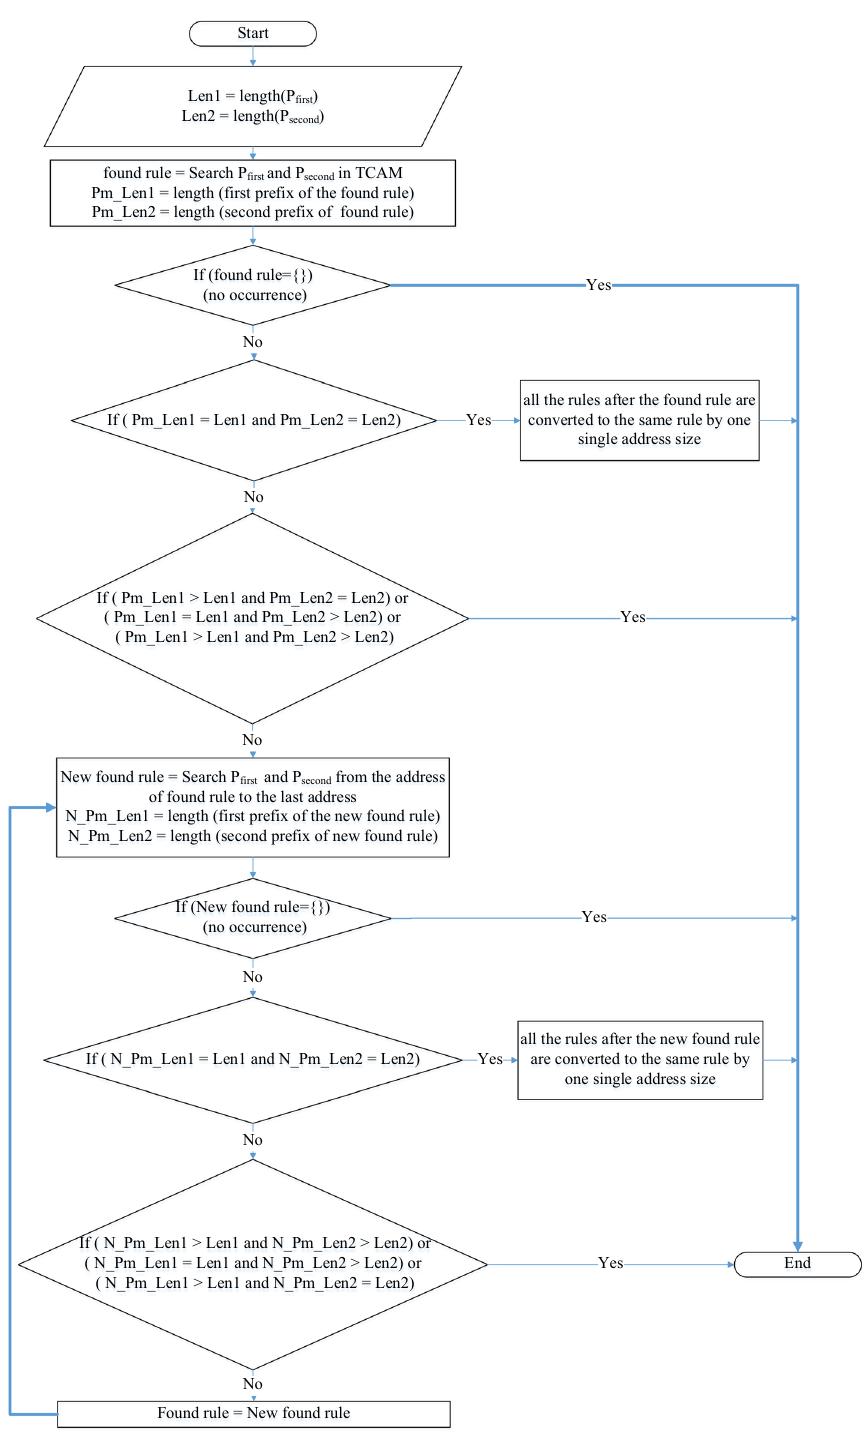
Fig. 5 The Flowchart of deleting the rule in the first